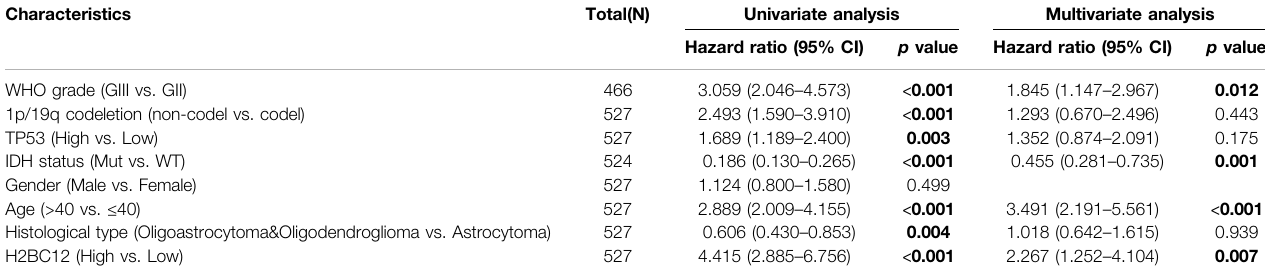
TABLE 3 | Correlations between overall survival and mRNA expression of H2BC12 analyzed by univariate and multivariate Cox regression. Characteristics